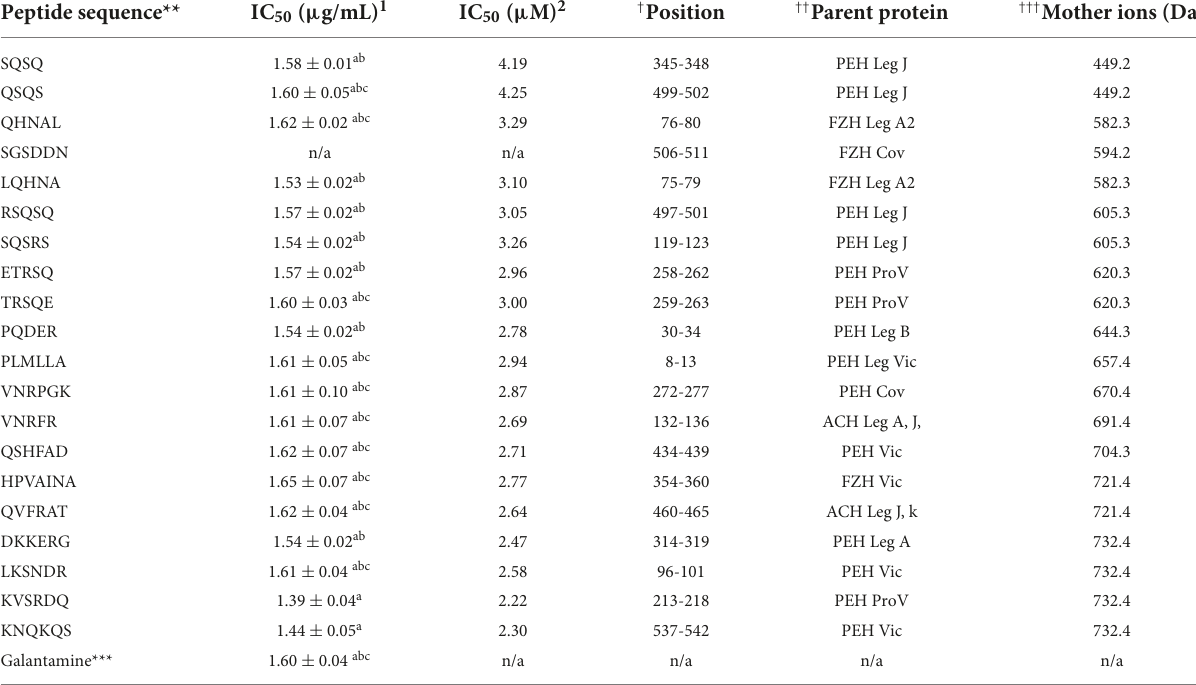
TABLE 1 Peptide location within the primary structure of pea proteins and their inhibitory potency against acetylcholinesterase. Peptide